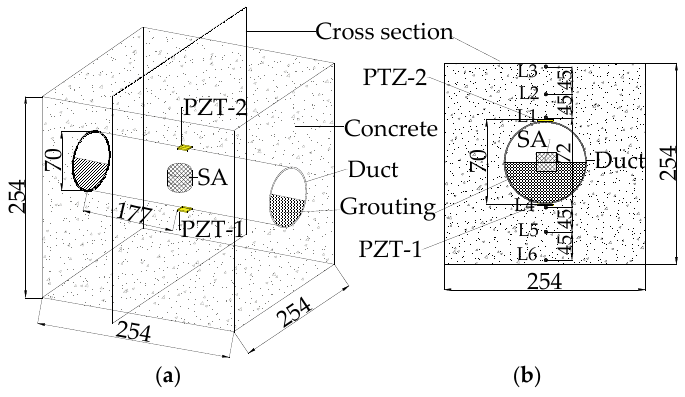
Figure 1. The geometric details of the grouting compactness monitoring model (unit: mm). ( a ) 3-dimensional view of the test specimen. ( b ) Sectional view of the specimen.